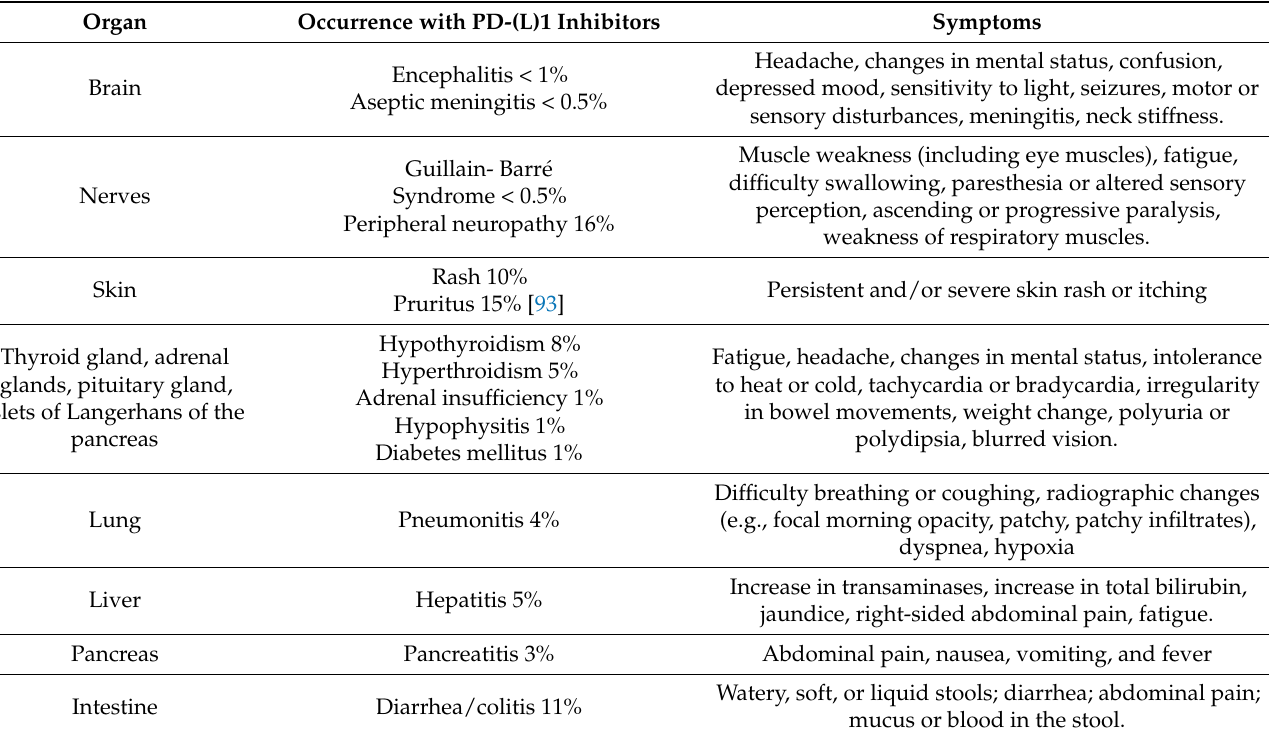
Table 5. Immune-mediated adverse effects of immune checkpoint inhibitors.